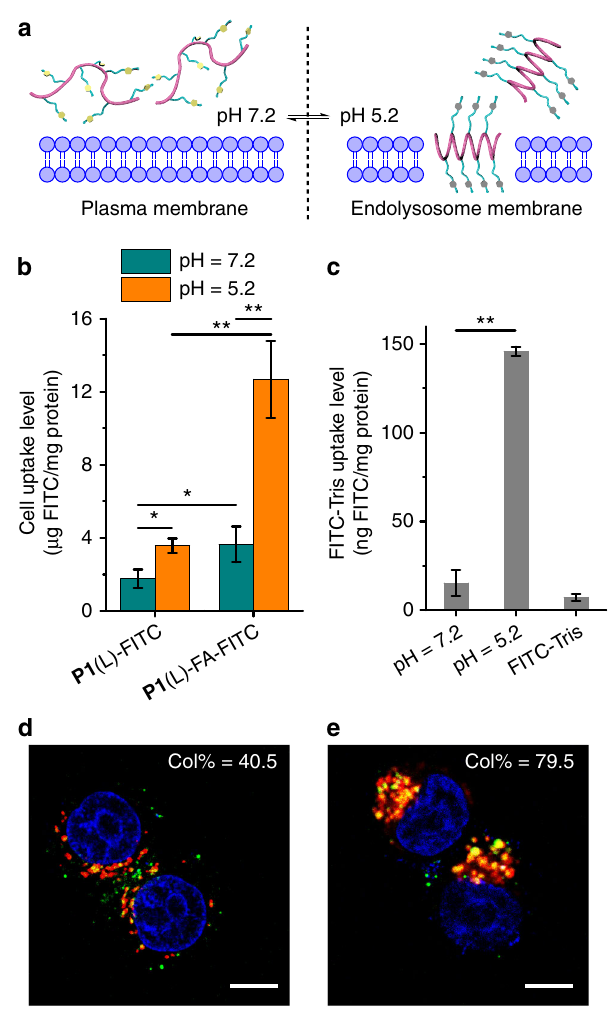
Fig. 5 Triazole polypeptides mediate cancer cell-targeted internalization and acid-induced endosomal escape. a Scheme showing pH-dependent membrane penetration of P1 . b Cell uptake of P1 (L)-FITC and folic acid (FA)-modi fi ed polypeptide P1 (L)-FA-FITC in HeLa cells at pH 7.2 and 5.2. Results represent the means ± s.e.m. of three replicates. c Uptake level of FITC-Tris in HeLa cells after co-incubation with P1 at pH 7.2 and 5.2. Results represent the means ± s.e.m.of three replicates. d , e Merged CLSM images of HeLa cells following incubation with P1 (L)-FA-FITC ( d ) or P1 (DL)-FA-FITC ( e ) at 37 °C for 4 h. Cell nuclei were stained with Hoechst 33258 ( blue ) and endosomes/lysosomes were stained with Lysotracker Red ( red ). Scale bar represents 10 μ m. Col% represents the colocalization ratio of P1 (L)-FA-FITC or P1 (DL)-FA-FITC ( green ) with Lysotracker Red ( red ) ( n =